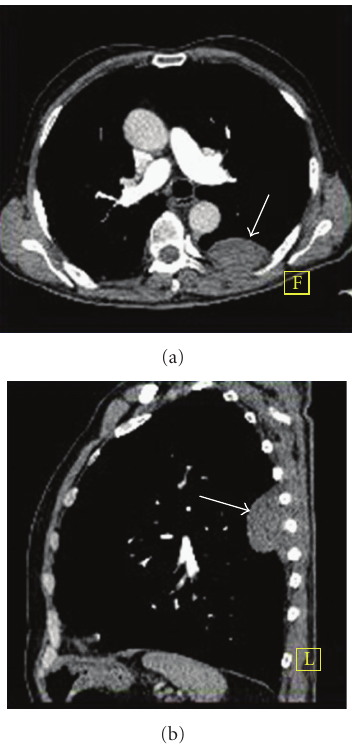
Figure 1: Axial (a) and sagittal (b) CT images demonstrate a lesion in the upper lobe of the left lung invading pleura and adjacent ribs (arrows).